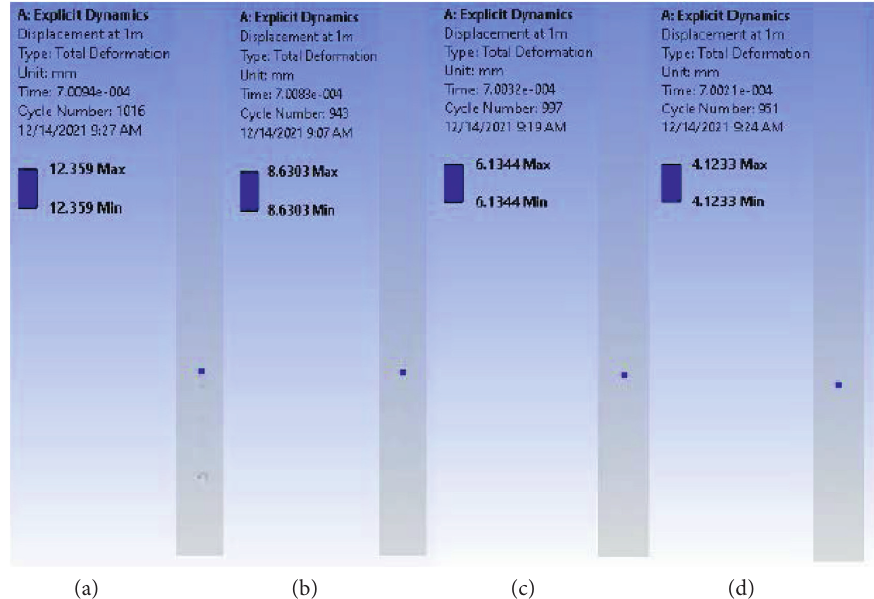
Figure 5: Nodal displacement value for CONV_20 RC column located at 1m control point: (a) 20mm; (b) 25mm; (c) 30mm; (d) 40mm.